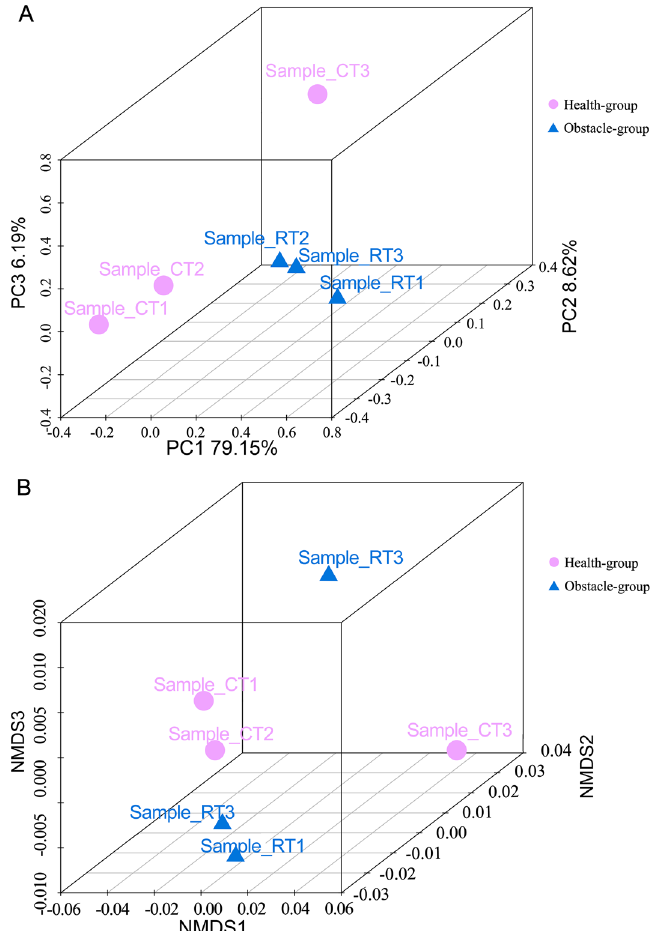
Figure 3. Beta diversity among samples sequenced. ( A ) The principal co-ordinates analysis (PCoA) results. ( B ) The Nonmetric Multidimensional Scaling (NMDS) analysis results. Both analyses were performed based on the Euclidean distance algorithm.